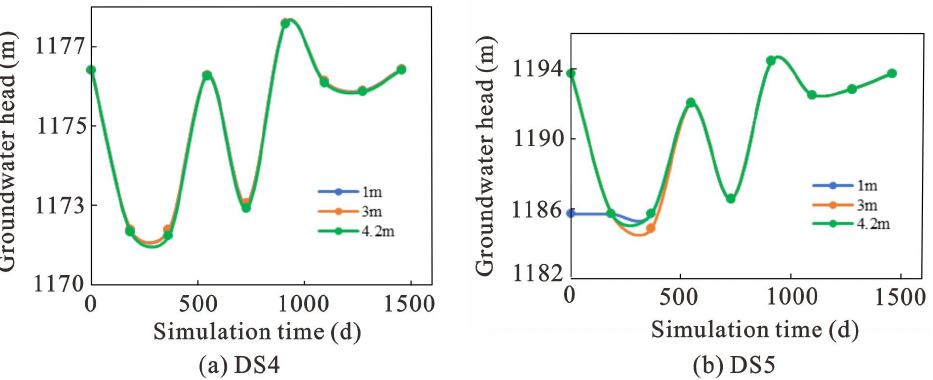
Figure 10. Variation in groundwater level in the lower aquifer system under different thicknesses of coal seam: ( a ) DS4, ( b ) DS5. Note: As the water-level change is not obvious, these graphs are zoomed in.